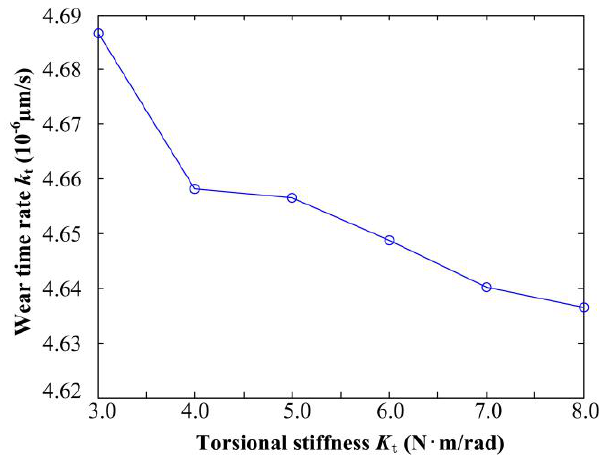
ff erent torsional sti ff ness values.